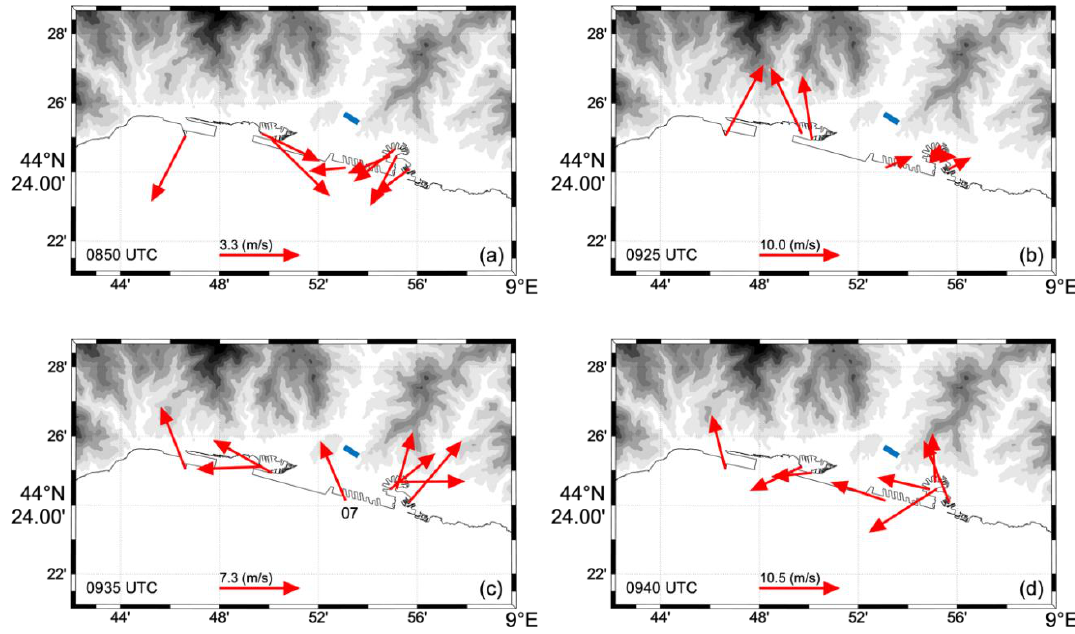
Figure 12. Vectors of the wind velocity measured by the 8 anemometers in the Port of Genoa before ( a ) and during ( b) –( d ) the thunderstorm.